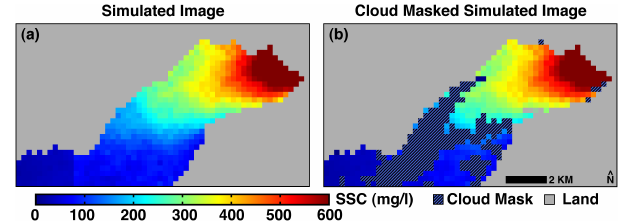
Figure 6. Example of (a) simulated image and (b) cloud masked simulated image for Watson River region of interest (ROI).